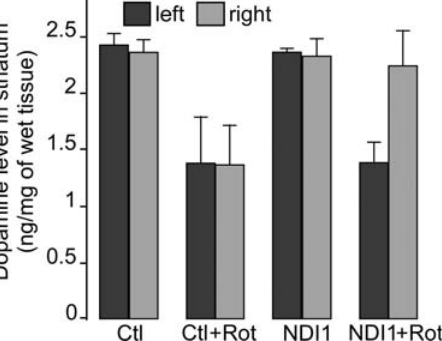
Figure 4. Reduction of striatal dopamine by rotenone exposure and its retention by expression of the Ndi1 protein. Procedures for the NDI1 gene injection and rotenone exposure were the same as those described in Figure 2. The striatal portions of unfixed brains were dissected and homogenized. Samples were analyzed for dopamine contents on an HPLC system coupled with an electrochemical detector. The dopamine contents were determined for the left and right hemisphere from the four groups, Ctl (n=3), Ctl + Rot (n=8), NDI1 (n=3) and NDI1 + Rot (n=11). n=number of animals. All values are presented with standard